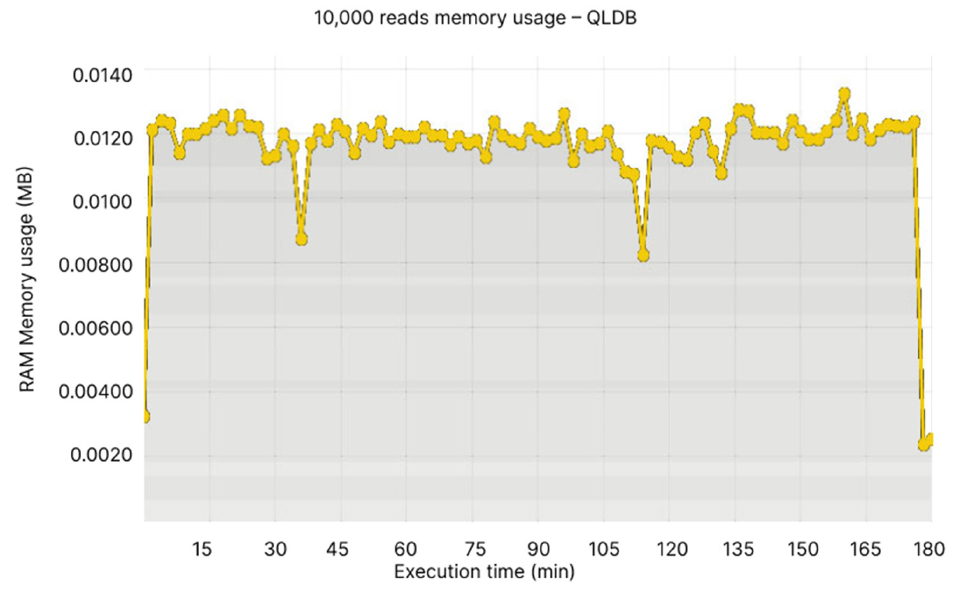
Figure 27. 10,000 reads CPU usage—QLDB.